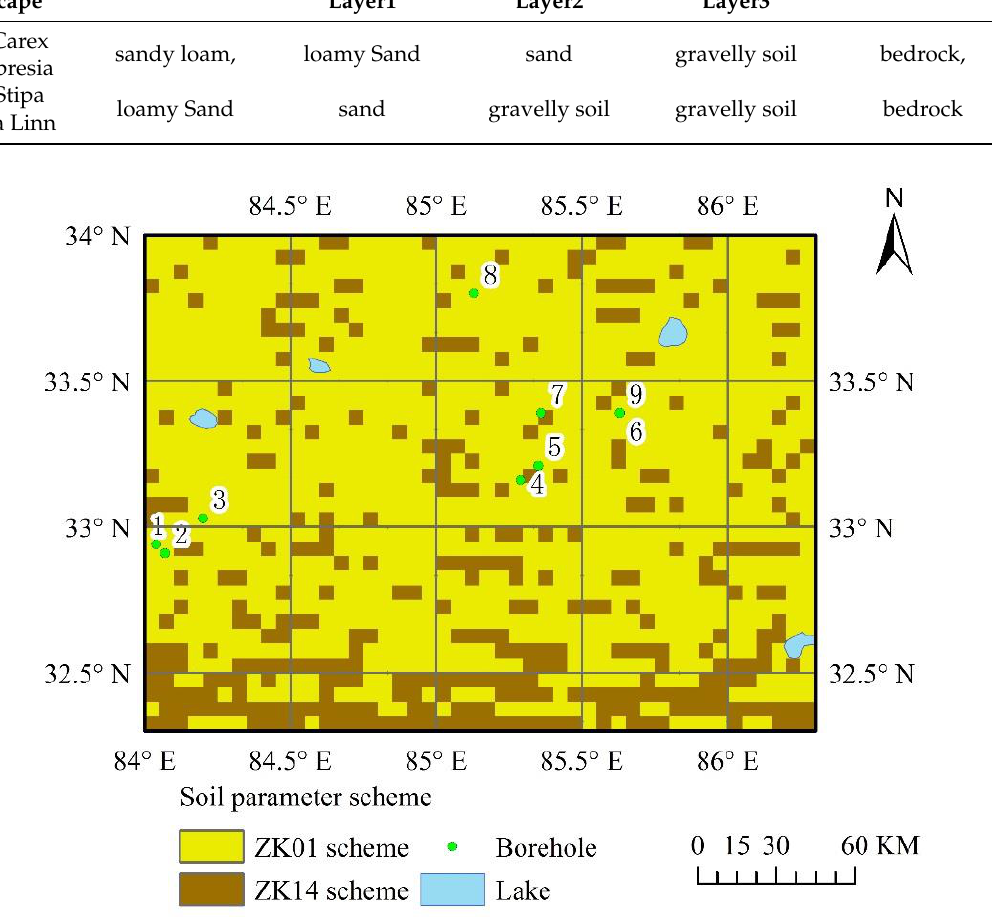
Figure 3. Distribution of soil parameter schemes in the Gaize area (Borehole number 1 to 9 correspond to the borehole ID in Table 1).